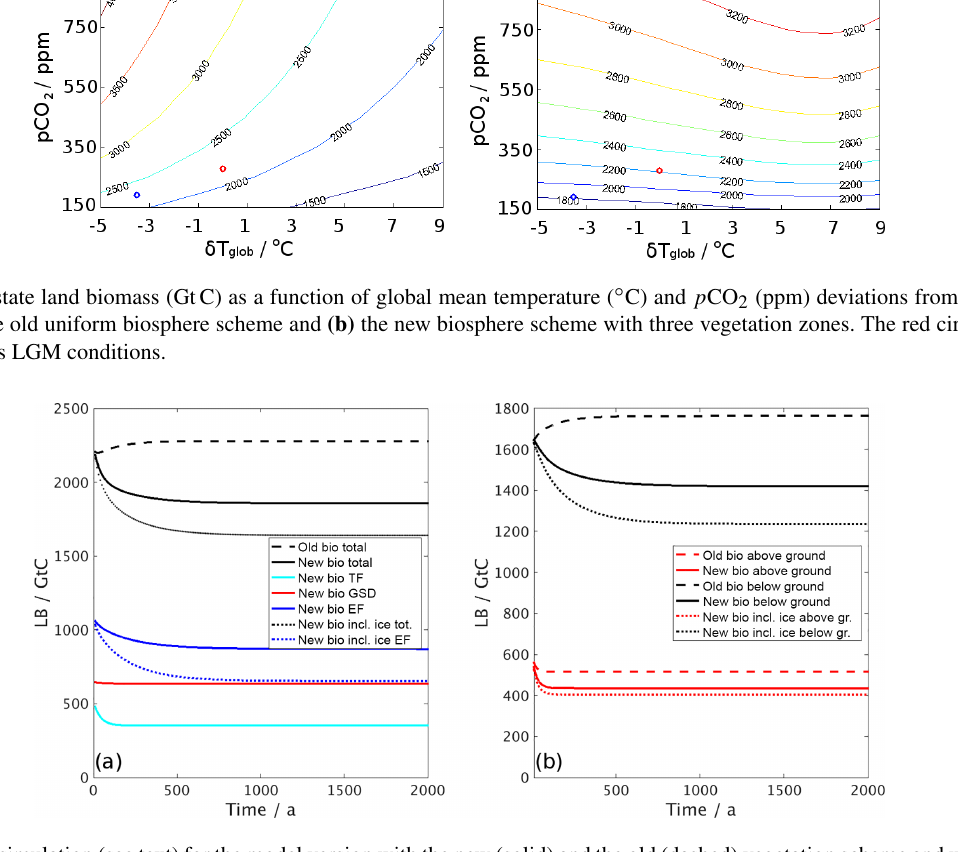
Figure 4. Cooling simulation (see text) for the model version with the new (solid) and the old (dashed) vegetation scheme and with prescribed ice sheet line to 47 ◦ latitude (dotted). (a) Total land biomass carbon (in black) and separated into the three vegetation zones (TF: cyan; GSD: red; EF: blue) for the new vegetation scheme. (b) Land biomass carbon separated into the reservoirs above ground (leaves + wood) in red and below ground (litter + soil) in